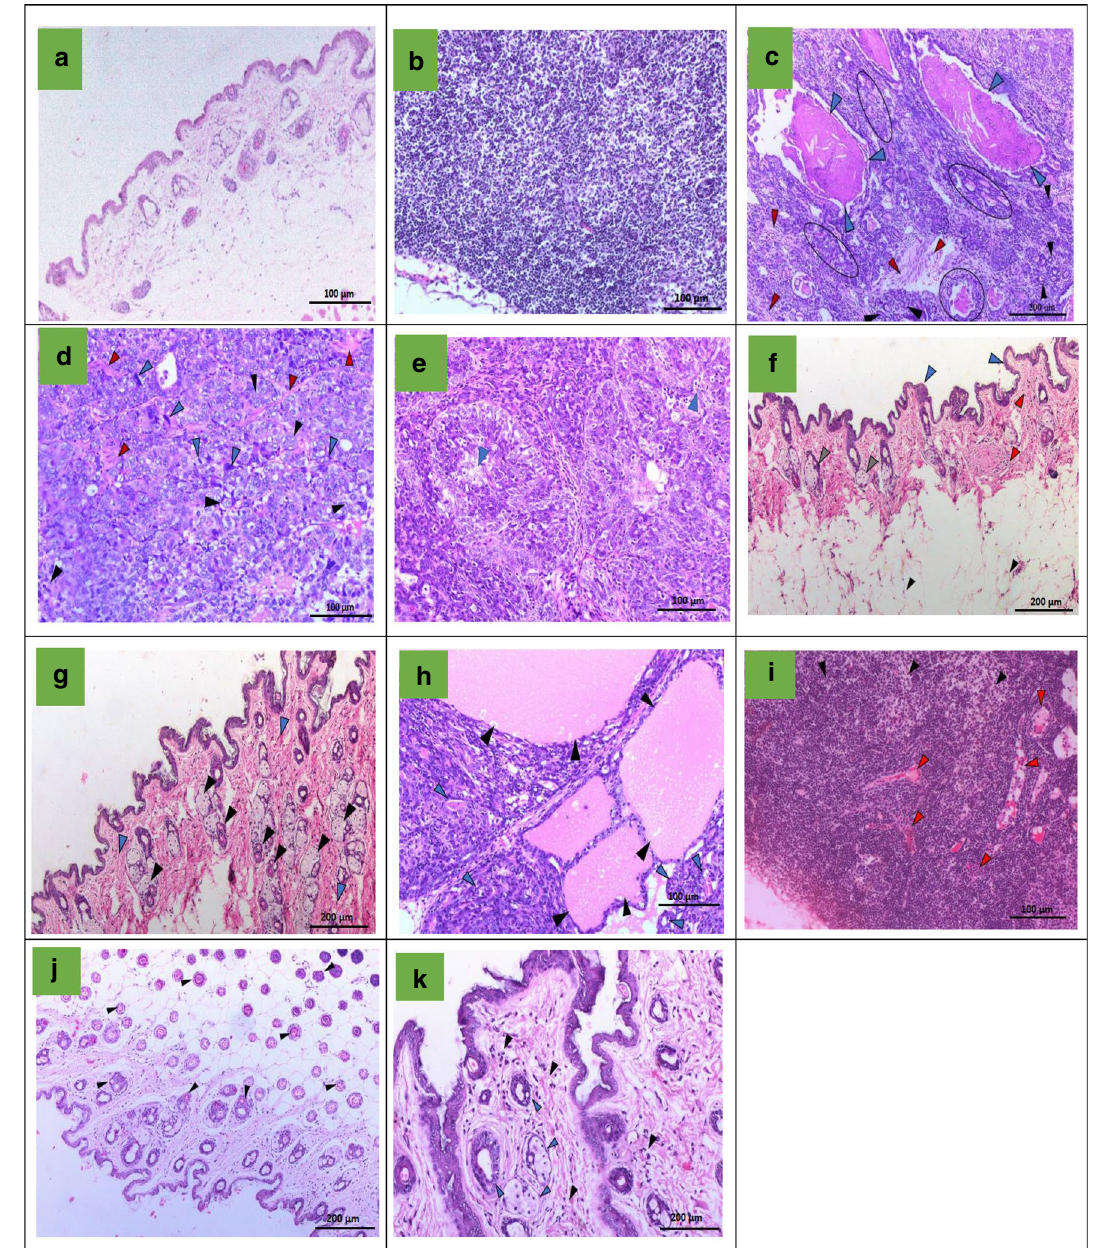
Fig. 3 The histological examination of breast tissue. a and b Control showing normal skin including epidermis and dermis, normal acini in ( a ), and intact mammary lymph node ( b ). c – e The DMBA group ( c ) ductal carcinoma with colloidal secretion (blue arrows), newly formed ductules (oval shapes), moderate fibrosis (red arrows), proliferated wall duct (round shape), and invasive ductal carcinoma (black arrows), d Nuclear polymorphism (black arrows), mitotic activity (blue arrows), fibrosis (red arrows), and e necrosis (blue arrows). f and g DMBA/BFB, f normal epidermis (blue arrows), free acini (black arrows), dermis showing mild inflammation (red arrows), hyperplasia in hair follicles and sebaceous glands (gray arrows), g Hyperplasia in skin appendages including hair follicles and sebaceous glands (black arrows), mild inflam- mation (blue arrows). h and i DMBA/TAM, h ductal carcinoma and accumulation of colloidal secretion in ducts and acini (black arrows), newly formed ductules (blue arrows). i Hyperplasia of lymphoid follicles (black arrows) and congestion of blood vessels (red arrows). j and k BFB group, j normal epidermis, free acini, mild inflammation, hyperplasia in hair follicles and sebaceous glands and hair follicles in dermis (black arrows) and k hyperplasia in hair follicles and sebaceous glands (blue arrows), mild inflammation (black